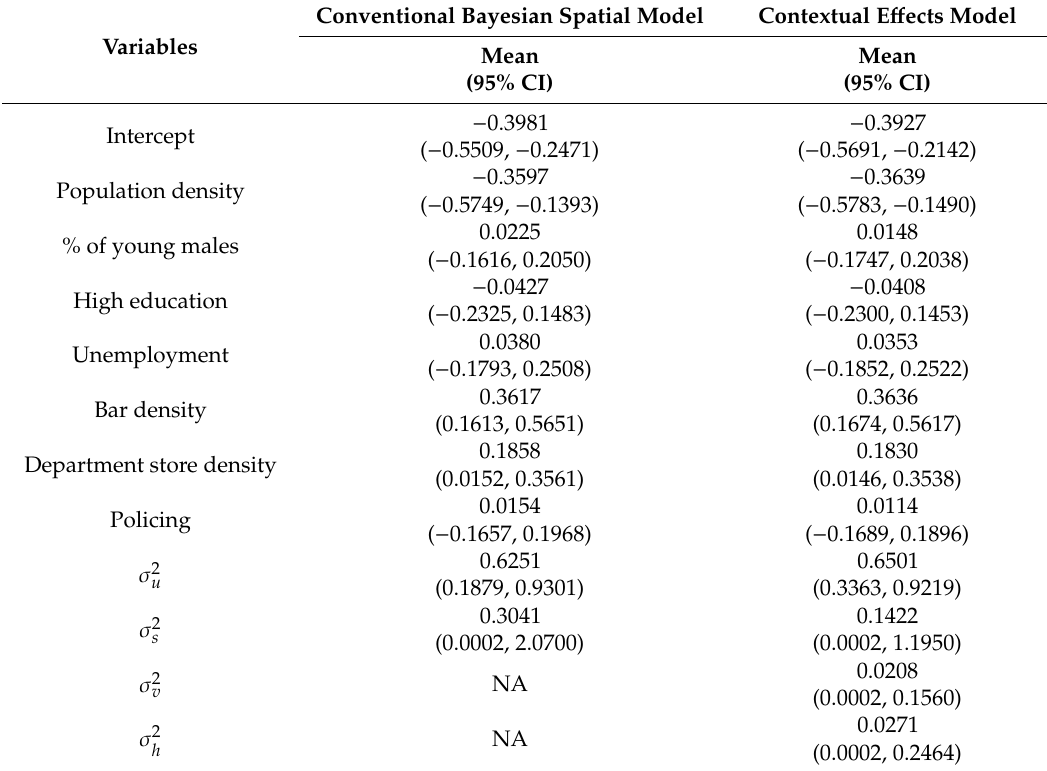
Table 3. The intercept term, regression coe ffi cients, and variance parameters estimated by the two